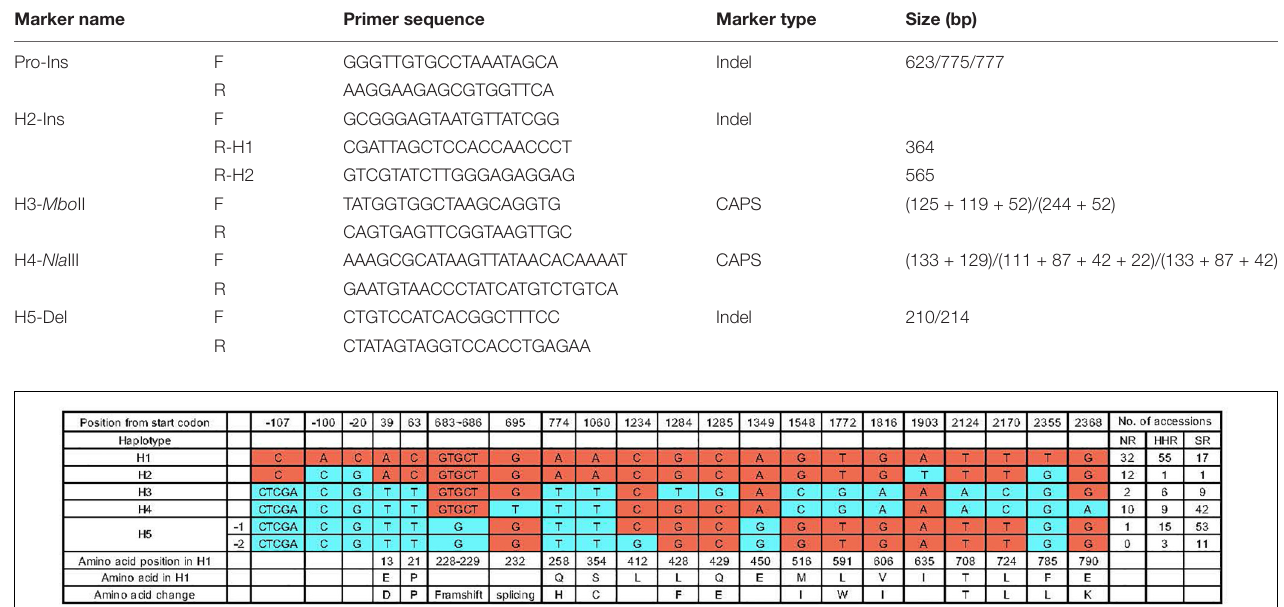
TABLE 1 | Haplotype-specific markers for GmSALT3 .